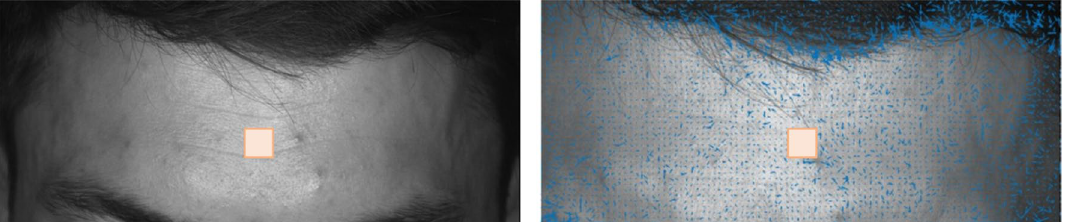
Figure 6. Mimics and light change comparison (at the start—frame 1, in the middle of cold pressure test— frame 25,989). Blue colour depicts motion estimated by optical